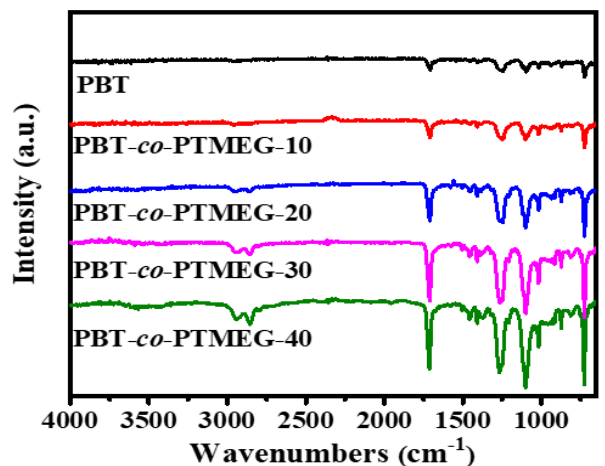
Figure 2. FT-IR spectra of PBT and PBT- co -PTMEG copolymers.